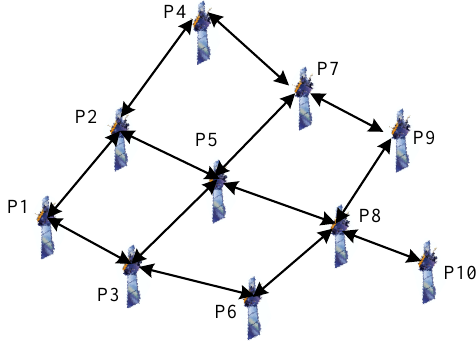
Figure 6. The topology of the sensor network with 10 observation platforms.